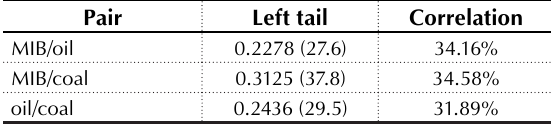
Table 5. Left tail parameter estimation and correlation for some pairs of simulated variables (number of cases between parentheses) Pair Left tail Correlation